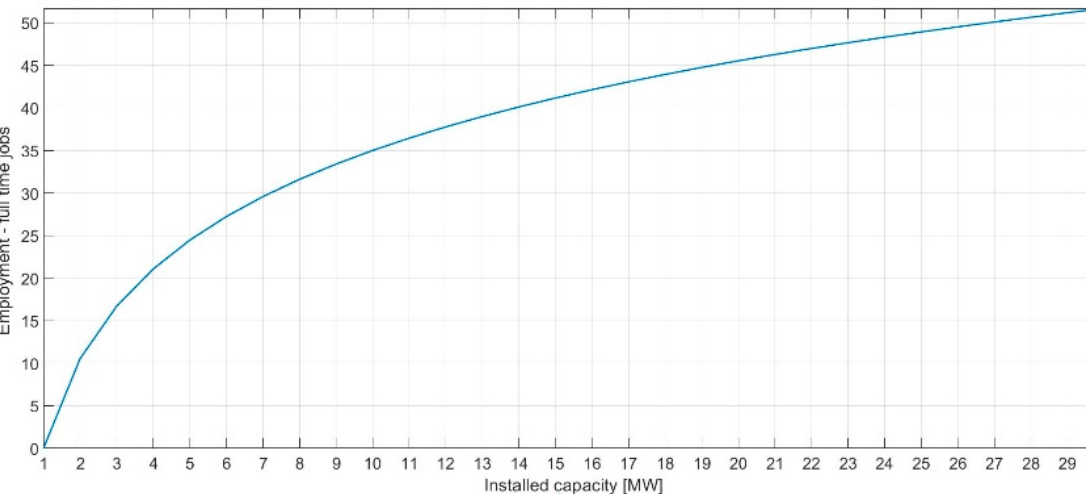
Figure 6. Total employment – full-time jobs function depending on the installed capacity of the project